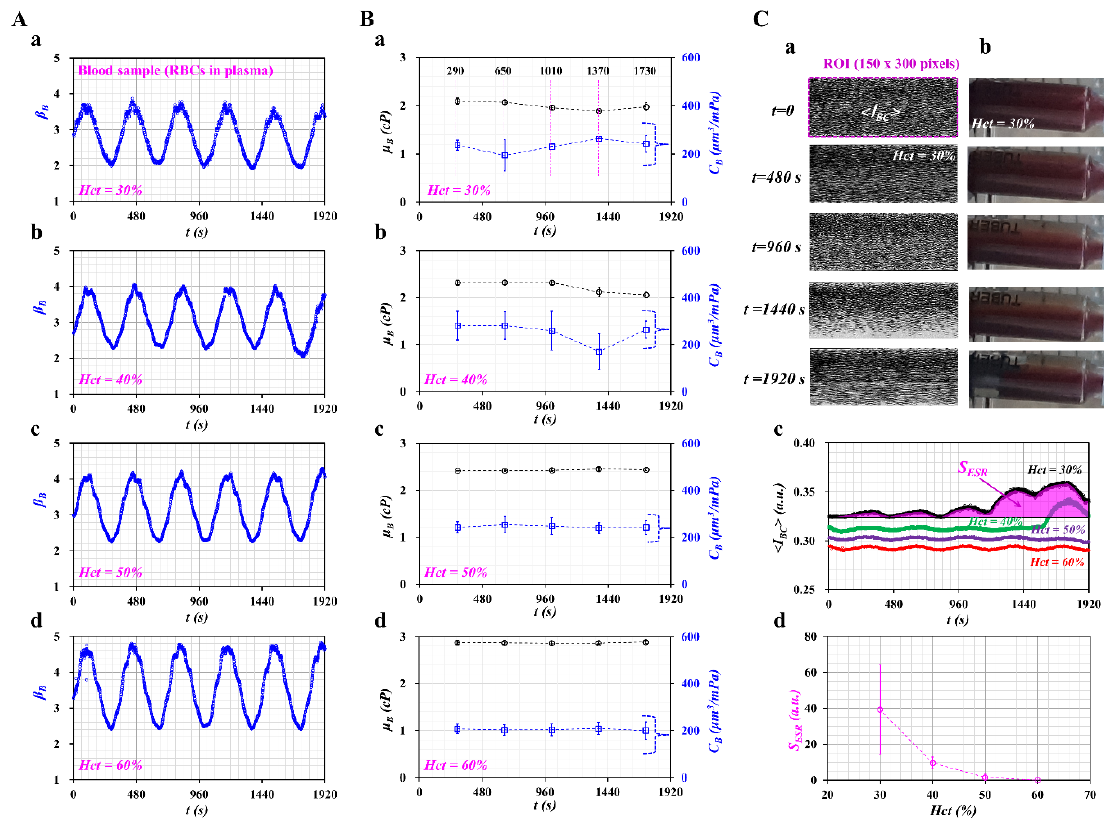
Figure 4. Contribution of hematocrit ( Hct ) to viscoelasticity and ESR. Blood samples ( Hct = 30%, 40%, 50%, and 60%) were prepared by adding normal RBCs into plasma. ( A ) Temporal variations of β B with respect to hematocrit (( a ) Hct = 30%, ( b ) Hct = 40%, ( c ) Hct = 50%, and ( d ) Hct = 60%). ( B ) Temporal variations of μ B and C B with respect to hematocrit (( a ) Hct = 30%, ( b ) Hct = 40%, ( c ) Hct = 50%, and ( d ) Hct = 60%). ( C ) Evaluation of ESR occurring in driving syringe. ( a ) Microscopic images of blood sample ( Hct = 30%) flowing in blood channels over time ( t = 0, 480, 960, 1440, and 1920 s). ( b ) Side view of a driving syringe over time ( t = 0, 480, 960, 1440, and 1920 s). ( c ) Temporal variations of < I BC > with respect to Hct. ( d ) Variations of S ESR with respect to Hct .